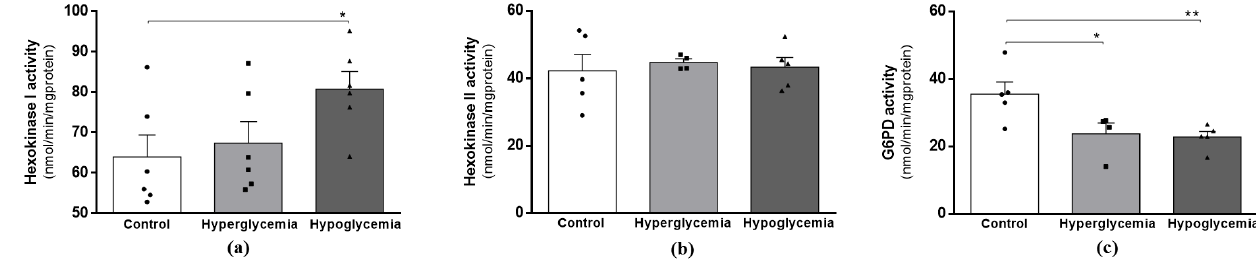
Figure 2. Effects of long-term hyperglycemia and insulin-induced recurrent hypoglycemia on the first steps of the metabolism of glucose. Hexokinase activity in ( a ) brain cortical isolated mitochondria and in ( b ) brain cortical tissue lysates from control, hyperglycemic and insulin-induced recurrent hypoglycemic rats. ( c ) G6PD activity in brain cortical tissue lysates from control, hyperglycemic and insulin-induced recurrent hypoglycemic rats. Data represent the mean ± SEM of the quantification of samples from 4–6 animals under each condition studied. ** p < 0.01 and * p < 0.05 were considered statistically significant differences. G6PD—Glucose-6-phosphate dehydrogenase.